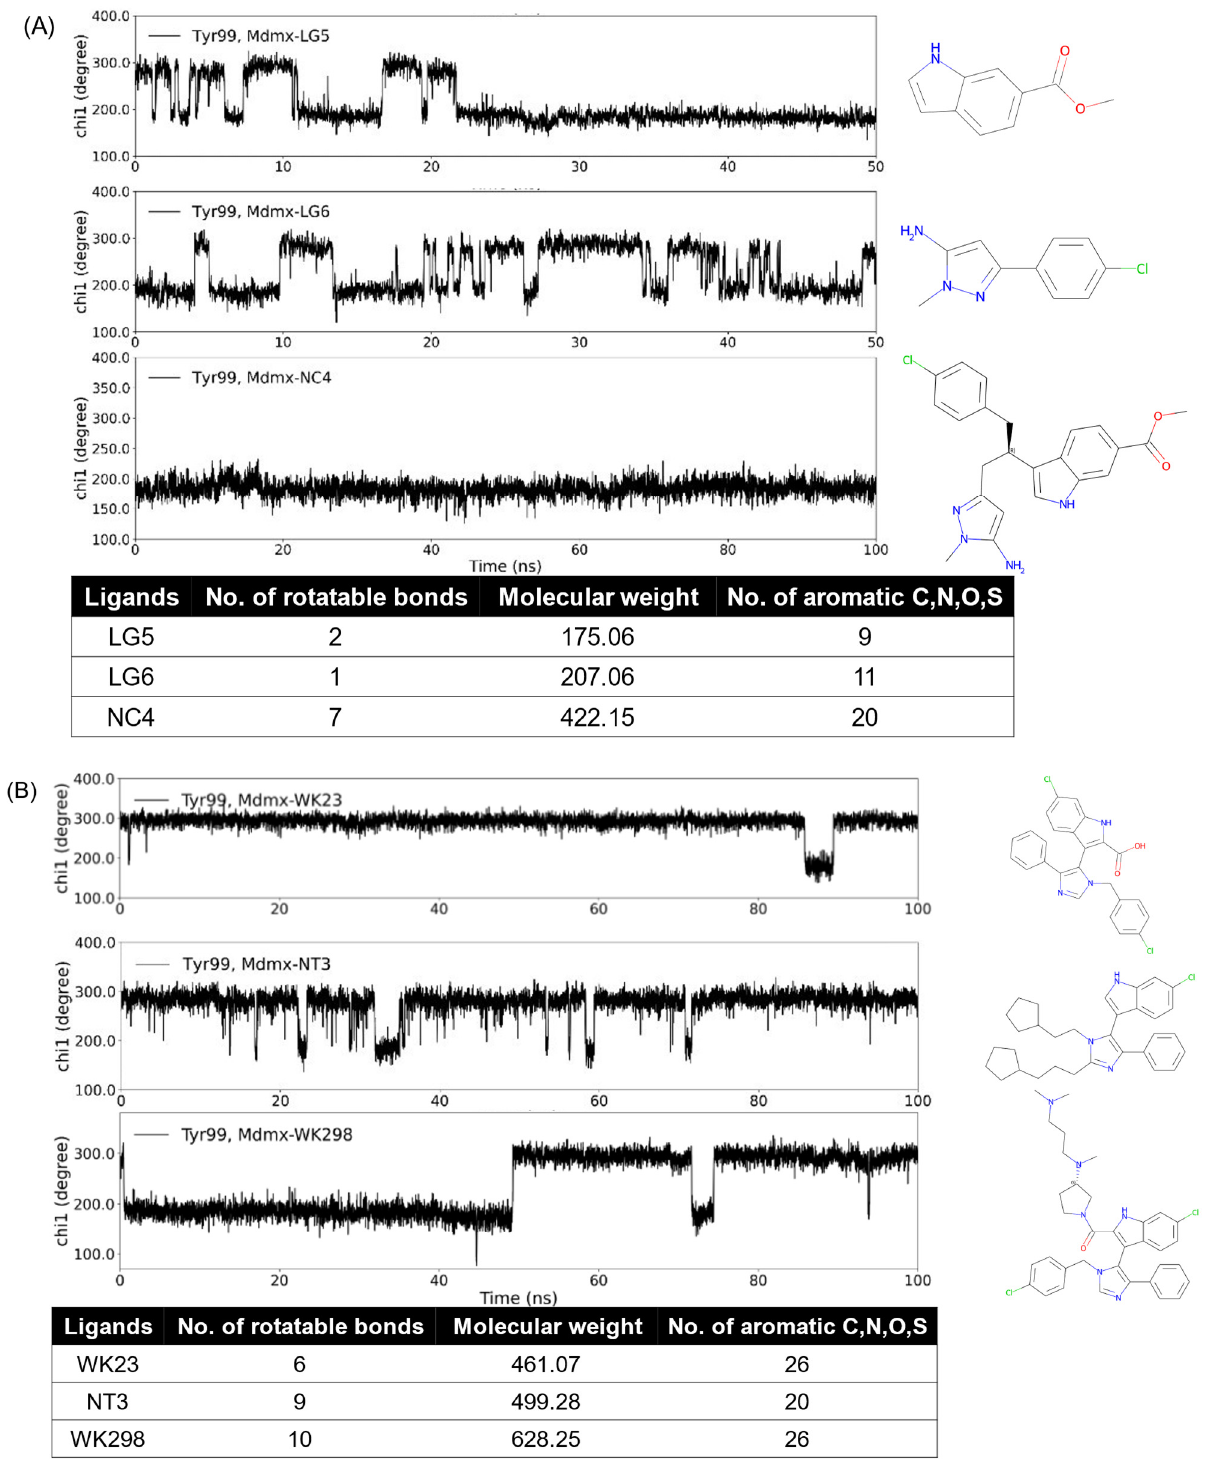
Figure 4. MD simulations and structural features of Mdmx inhibitors. WK23 (non-inducer) and WK298 (inducer) are known Mdmx inhibitors, while the others are computationally predicted structures. The open conformation of Mdmx corresponds to Tyr99 χ 1 of around 180°, while the closed one has χ 1 of around 300°. Dynamic changes in χ 1 in Mdmx complexes with the analyzed ligands show differences in binding properties of inducers (NC4 and WK298) as compared to the other analyzed ligands. NC4 and WK298 have more data points of χ 1 around 180°, i.e., more open states; the others have more data points of χ 1 around 300°, i.e., more closed states.